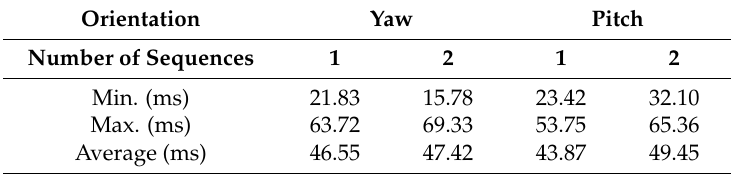
Table 2. Minimum, maximum, and average motion-to-photon latencies by different position